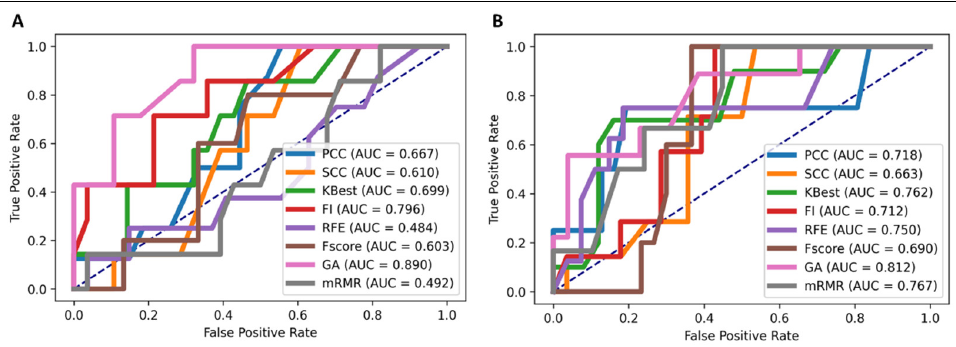
Figure 1. Predictive performance of different feature selection techniques in the NSCLC radioge- nomics model. The genetic algorithm (GA) demonstrated the most favorable performance. ( A ) EGFR mutation prediction (area under the curve (AUC) = 0.89), ( B ) KRAS mutation prediction (AUC = 0.812).